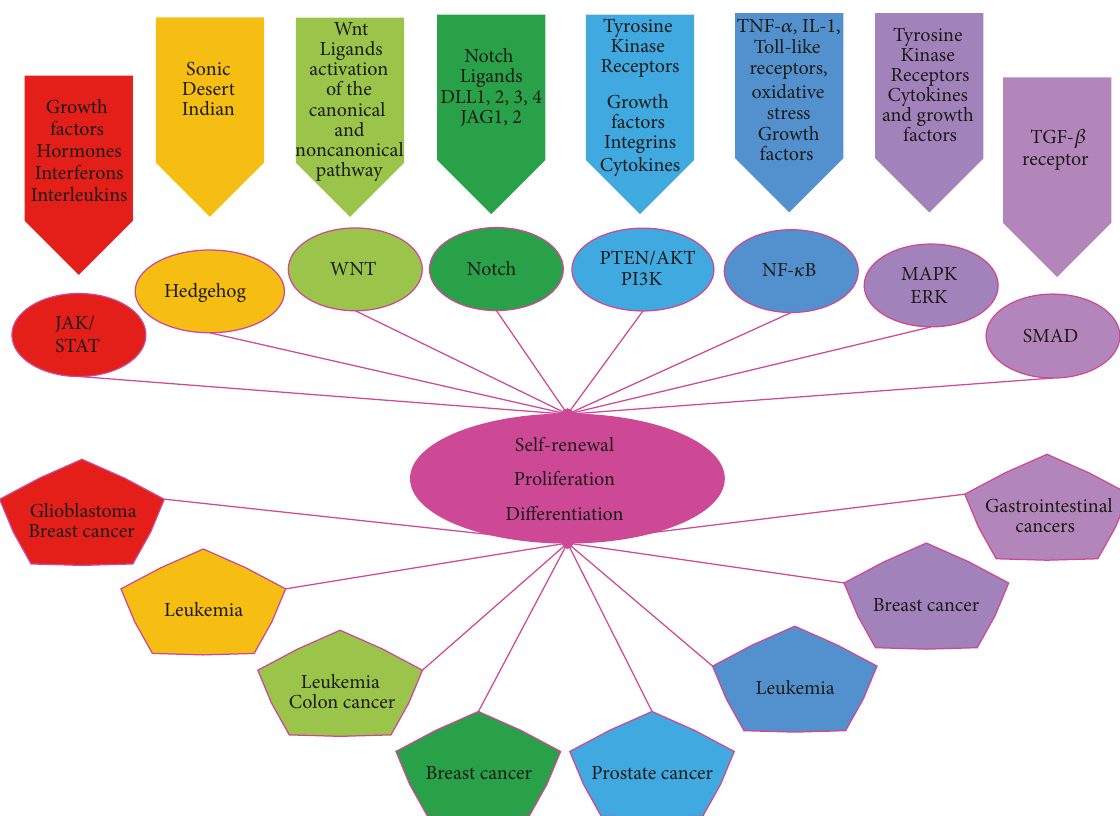
Figure 2: Common signaling pathways between Stem Cells (SCs) and Cancer Stem Cells (CSCs) [48]. CSCs share common signaling pathways, like the JAK/STAT, Hedgehog, Wnt, Notch, PTEN/AKT/P13K, NF- 𝜅 B, MAPK/ERK, and SMAD. These SCs mechanisms are altered in CSCs and are characteristic of the cancer types mentioned. The JAK/STAT pathway (Janus kinase/signal transducer and activator of transcription) is mainly involved in glioblastoma development and breast CSCs [49–52]. The Hedgehog pathways have effects on the patterning of the embryo but play a crucial role in the induction of myelogenous leukemia. Blocking of the Hedgehog pathway decreases the quantity ofCSCsin leukemia, then representing an important target forcancer therapy [53]. The Wnt pathway isan importantregulator of SCs and CSCs regarding self-renewal, being perturbed in colon cancer and leukemia [54–56]. The Notch pathway is involved in the development of breast tissue as a regulator of cell fate and differentiation. An excess in the activation of Notch could determine the aggressiveness of breast cancer [55, 57–59]. The phosphatase and tensin homolog (PTEN)/protein kinase B (PKB or AKT)/phosphatidylinositide 3-kinase (P13K) signaling is a key regulator of self-renewal and maintenance of SCs and CSCs with an important role in the emergence of CSCs in prostate cancer [51, 60]. The NF- 𝜅 B pathway is crucial for leukemic cells survival and its inhibition affects CSCs development in breast cancer [61]. It has been seen that the increase of neural stem cell (NSC) proliferation is caused by the activation of NF- 𝜅 B, through the TNF- 𝛼 signal transduction pathway, but its aberrant regulation could lead to CSCs development in glioblastomas [62, 63]. Blocking the mitogen-activated protein kinase (MAPK)/extracellular signal-regulated kinase (ERK) results in the growth inhibition of breast cancer and the emergence of CSCs, sensitizing cancer cells to chemotherapy [64–66]. Gastrointestinal SCs can be perturbed, changing their plasticity and differentiation potential by generating an aberrant response to TGF- 𝛽 affecting the SMAD pathway and generating CSCs [67]. The hepatocellular carcinoma is an aggressive form of cancer in which the TGF- 𝛽 , Notch, and Wnt are deregulated, also having consequences in the SMAD proteins and changing SCs renewal, differentiation, and survival patterns [68, 69]. In adult and CSCs systems all the mentioned pathways are common and conserved in the control of SCs renewal, proliferation, and